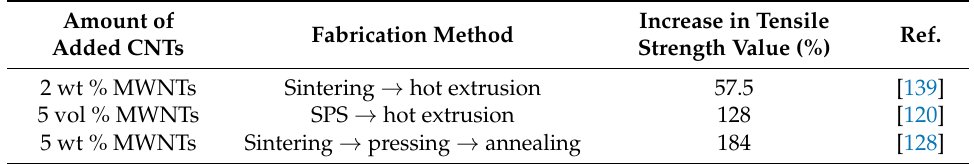
Table 3. The variation of tensile strength in CNT-dispersed Al matrix nanocomposites with the volume fraction of Al 4 C 3 precipitates (SPS: Spark plasma sintering).